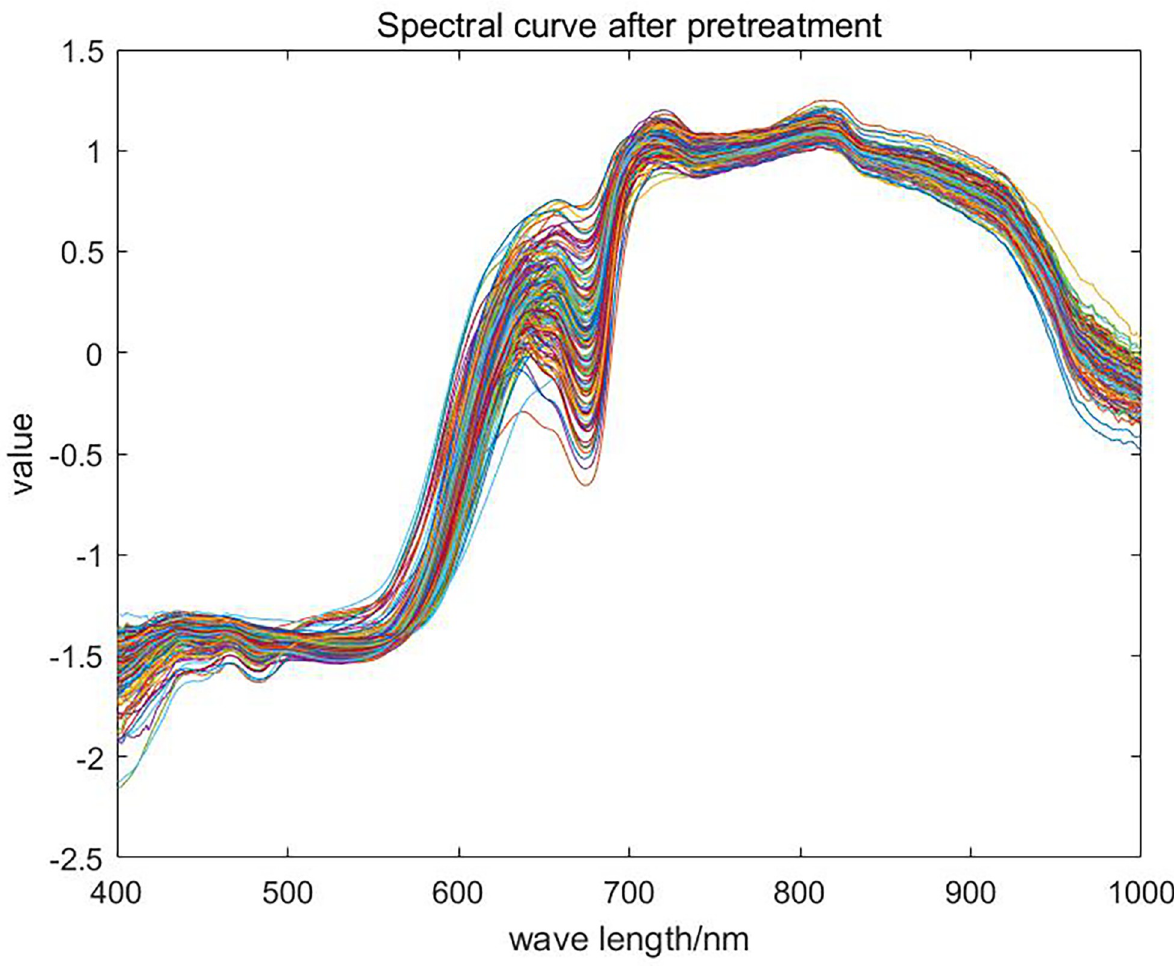
Fig 10. Spectral curves of samples after preprocessing.